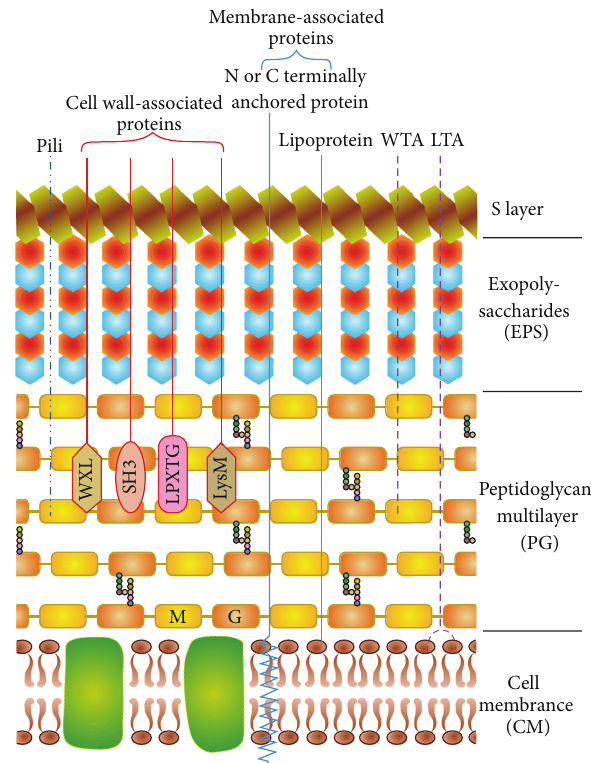
Figure 1: Cell envelope of lactobacilli with a schematic represen- tation of cell-wall and membrane-associated proteins (the figure was adapted from [35, 153]). The bilipidic cell membrane (CM) with embedded proteins is covered by a multilayered peptidoglycan (PG) shell decorated with lipoteichoic acids (LTA), wall teichoic acids (WTA), pili, proteins, and lipoproteins. Exopolysaccharides (EPS) form a thick covering closely associated with PG and are surrounded by an outer envelope of S-layer proteins. The proteins are attached to the cell wall either covalently (LPXTG proteins) or noncovalently (exhibiting LysM, SH3, or WXL domains), lipid anchored to the CM (lipoproteins) or attached to the CM via N- or C-terminal transmembrane helix. M: N-acetyl-muramic acid; G: N-